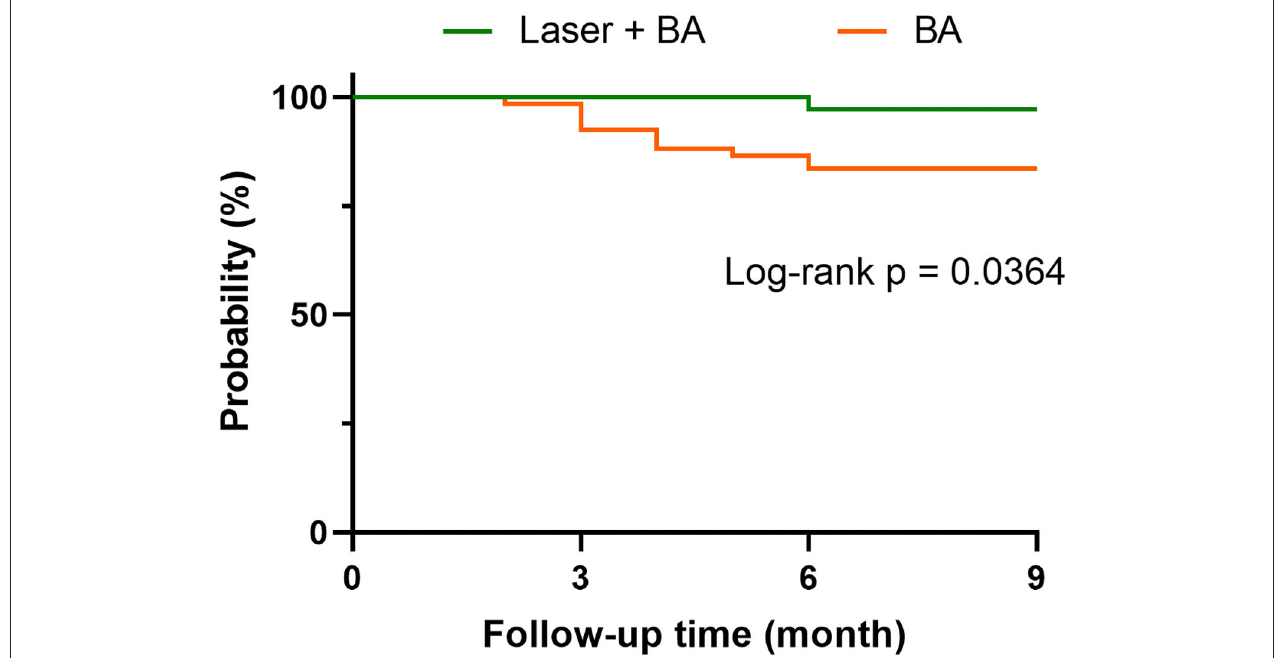
FIGURE 2 | The free from rehospitalization curves of laser-assisted angioplasty and BA groups. The case of rehospitalization includes reintervention, tissue loss, and